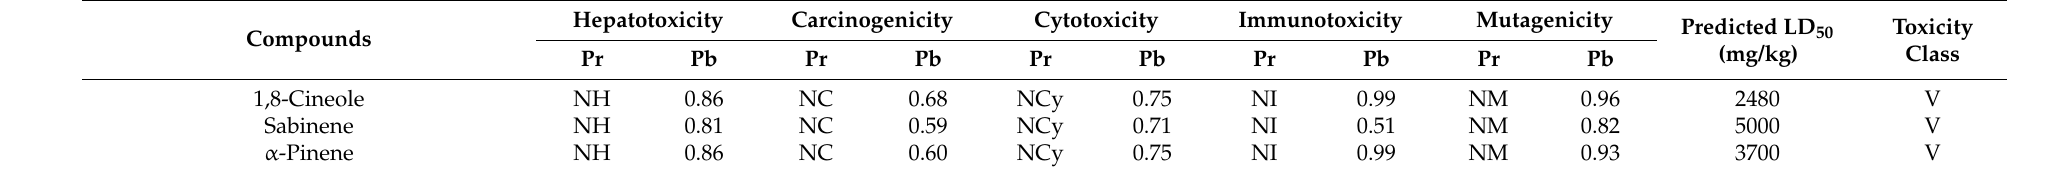
Table 6. Toxicological properties of selected compounds from VAO, VNO, and VTO. Hepatotoxicity Compounds